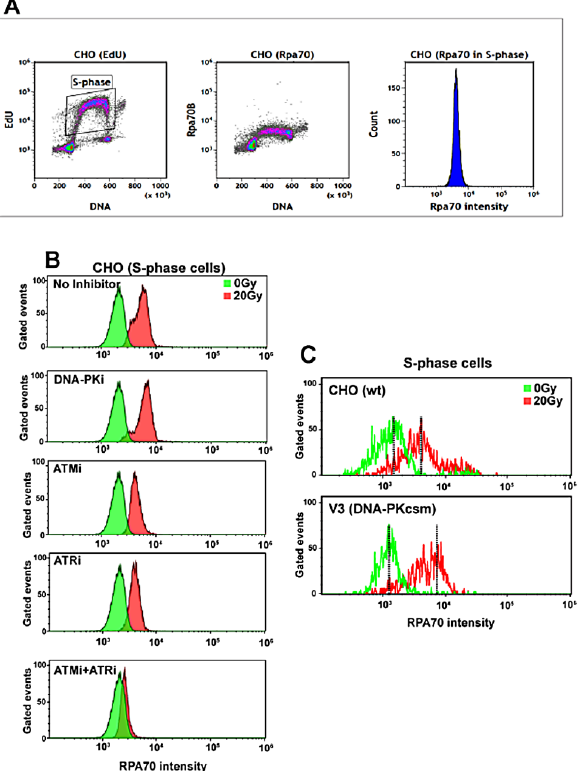
Figure 6. Degree of resection in S-phase cells correlates with intra-S-phase checkpoint activation: ( A ) Representative FACS histograms showing the S-phase specific gating scheme used to measure resection through analysis of RPA70 signal at 3 h post-IR, specifically in cells irradiated during S phase. ( B ) FACS overlays of CHO cells treated without or with the indicated PI3KK inhibitors. ( C ) FACS overlays of RPA70 signal in CHO and V3 cells exposed to the indicated doses of IR. Other details as in ( A ).